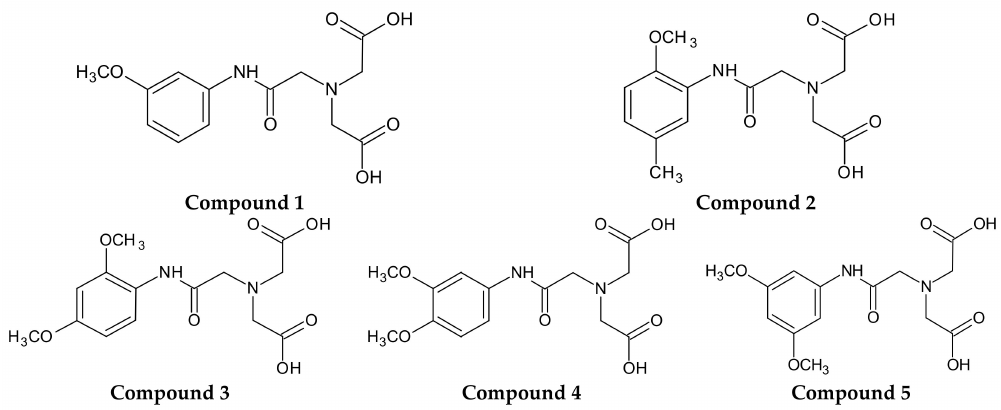
Figure 1. Synthesized derivatives of iminodiacetic acid